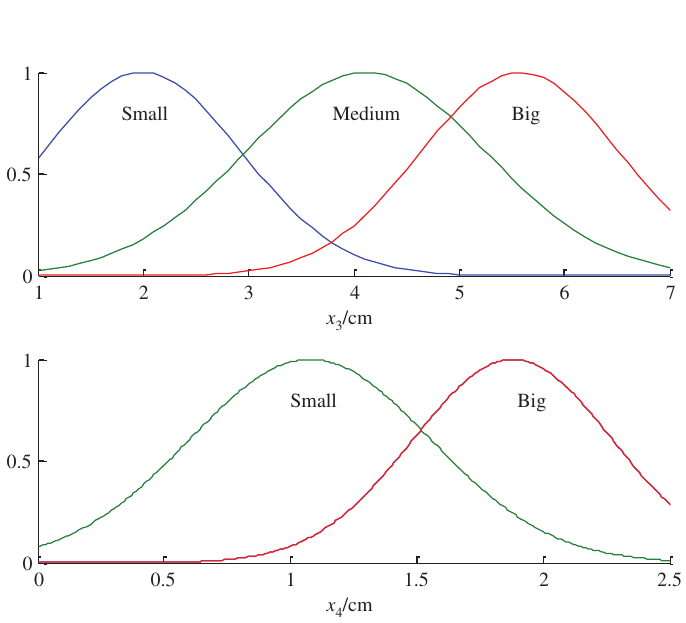
Figure 3: Membership Function of the Optimized Fuzzy